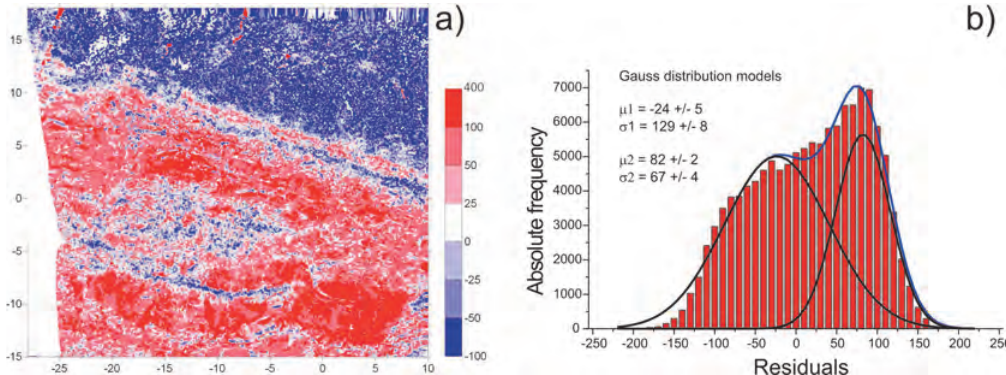
Fig. 10. Residuals map of B-zone and their statistical distribution. The residuals are computed as difference be- tween intensity and R component of the RGB image (see also fig. 4). The distribution is not-normal, but can be considered as overlap of two normal distributions whose means and standard deviations are also